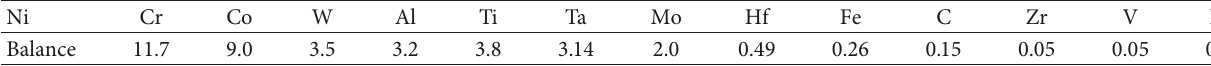
Figure 2: Isoplethic Ni-Al phase diagram of IN-792 superalloy. Table 1: Real chemical composition (wt. %) of IN-792 superalloy.